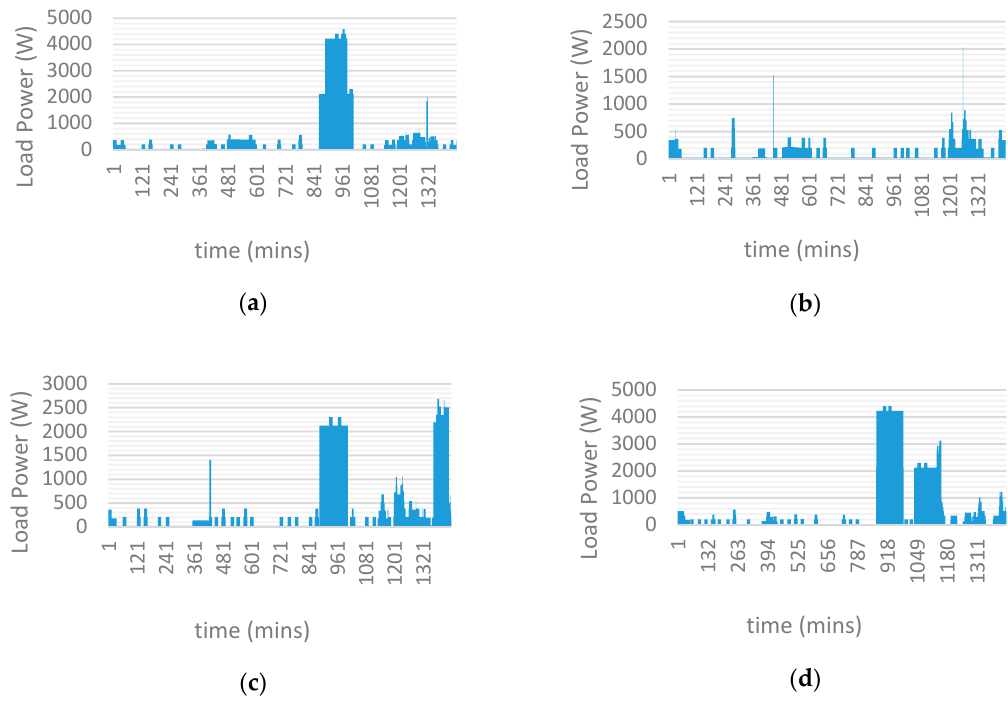
Figure 8. ( a )–( d ) Simulation result: load profiles of four common samples with four different load profile types.